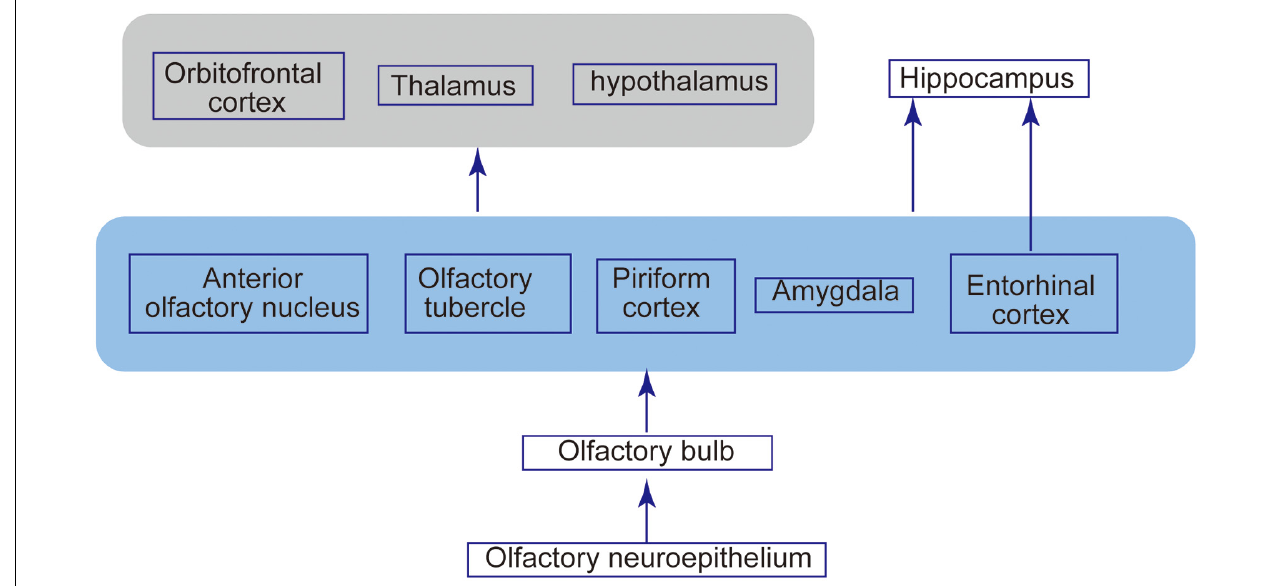
FIGURE 2 | Olfactory structures and neural connections. Odor molecules are perceived by odorant receptors expressed on the olfactory receptor neurons in the neuroepithelium. Olfactory signals are then sent intracranially to the OB and relayed to the second-order neurons, mitral cells, and tufted cells. These second-order neurons extend their axons along the lateral olfactory tract toward the structure of the primary olfactory cortex, such as the anterior olfactory nucleus, piriform cortex, and entorhinal cortex. This olfactory cortex has a projection extending to other brain areas, including the thalamus, hypothalamus, orbitofrontal cortex, and